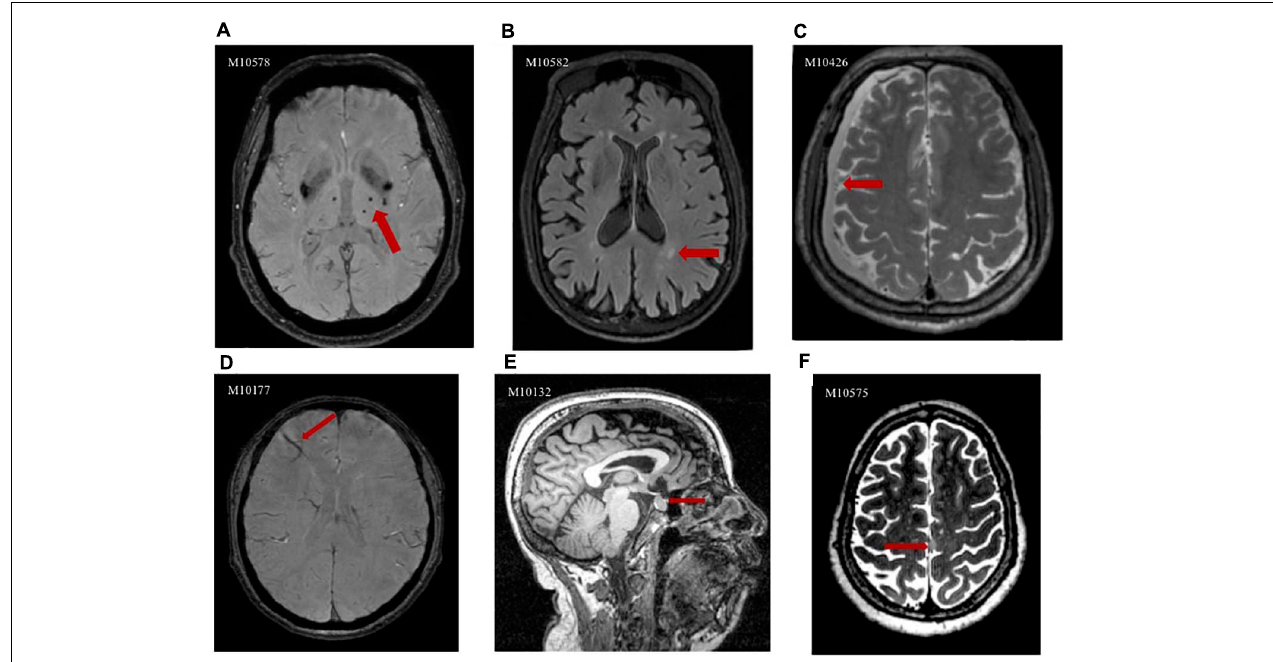
FIGURE 1 | Abnormalities incidentally discovered in the Shanghai Changfeng study IFs could be observed on different images; here are some examples; the imaging features of the abnormalities are indicated with red arrows in each case. (A) Axial SWI image clearly depicts CMBs in the thalamus as hypointense areas; (B) Axial FLAIR image shows hyperintense areas in the deep white matter, representing WMH; (C) Axial T2-weighted image depicts crescent-shaped lesion that is isointense relative to the cerebrospinal fluid, findings that indicate chronic subdural hematoma; (D) Axial SWI image reveals venous malformation in the frontal lobe as hypointense atypically shaped areas; (E) Sagittal T1-weighted image demonstrates well-defined rounded foci that are isointense relative to gray matter in the sella turcica, representing pituitary adenoma; (F) Axial T2-weighted image shows meningioma as a hyperintense extra-axial mass that associated with the falx